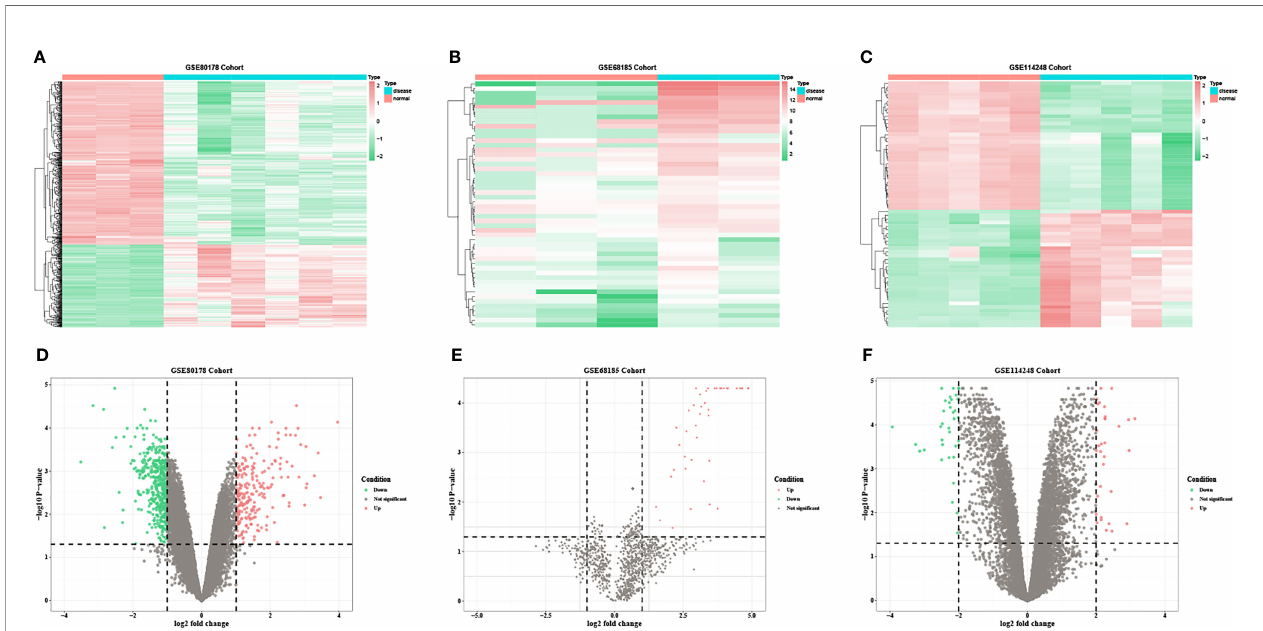
FIGURE 2 | The heatmap and volcano plots of DEmRNAs in GSE80178, DEmiRNAs in GSE68185, and DEcircRNAs in GSE114248. (A) Heatmap of DEmRNAs in GSE80178. (B) Heatmap of DEmiRNAs in GSE68185. (C) Heatmap of DEcircRNAs in GSE114248. (D) Volcano plot of DEmRNAs in GSE80178. (E) Volcano plot of DEmiRNAs in GSE68185. (F) Volcano plot of DEcircRNAs in GSE114248. Data points in red and green represent upregulated and downregulated,